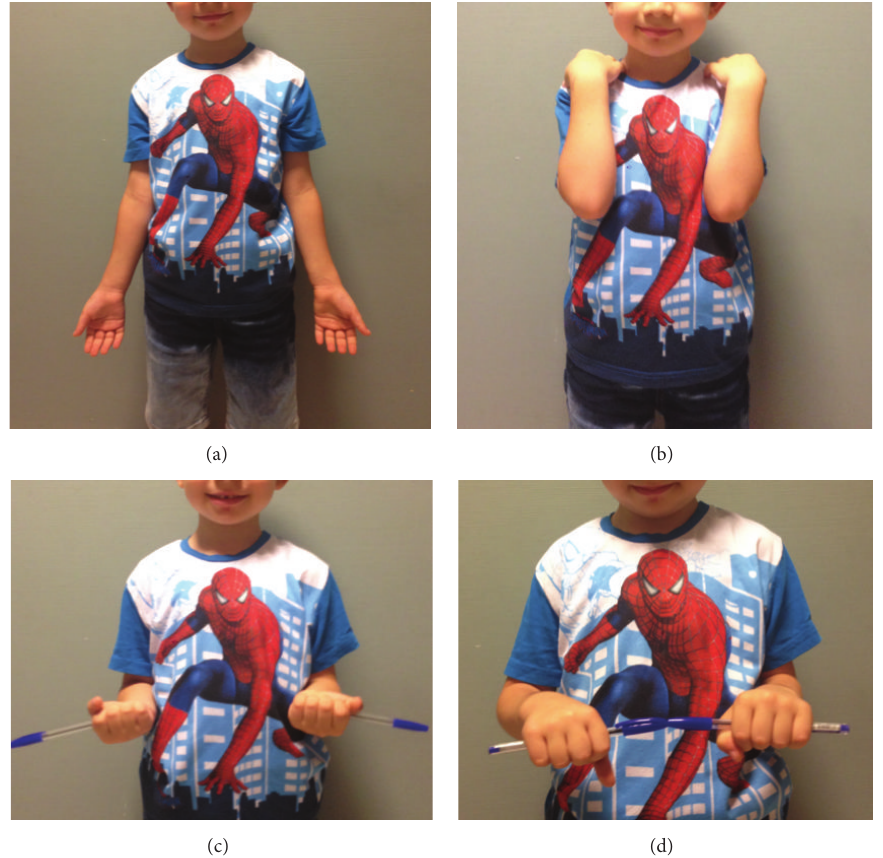
Figure 6: Clinical photos show full ROM of elbow and forearm rotation at the 8th